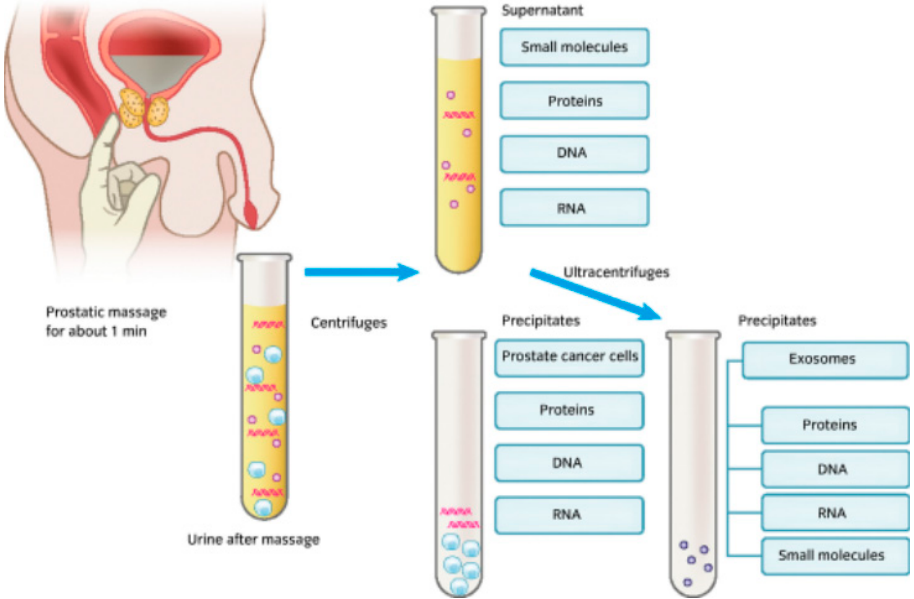
Figure 1. An image showing a form of urine collection involving prostate stimulation beforehand, the biomarker constituents within urine, and the laboratory-based constituent separation process